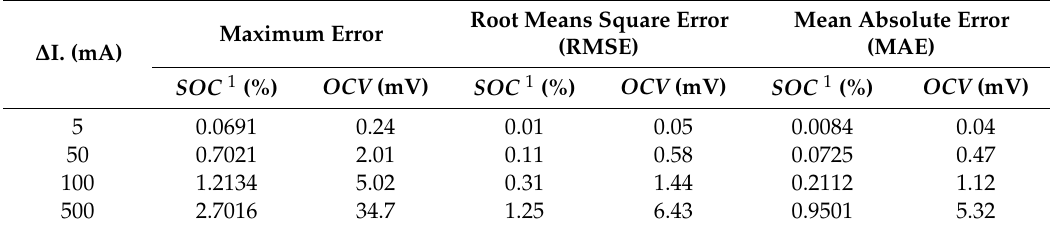
Table 6. Statistical error analysis at different values of current sensors.